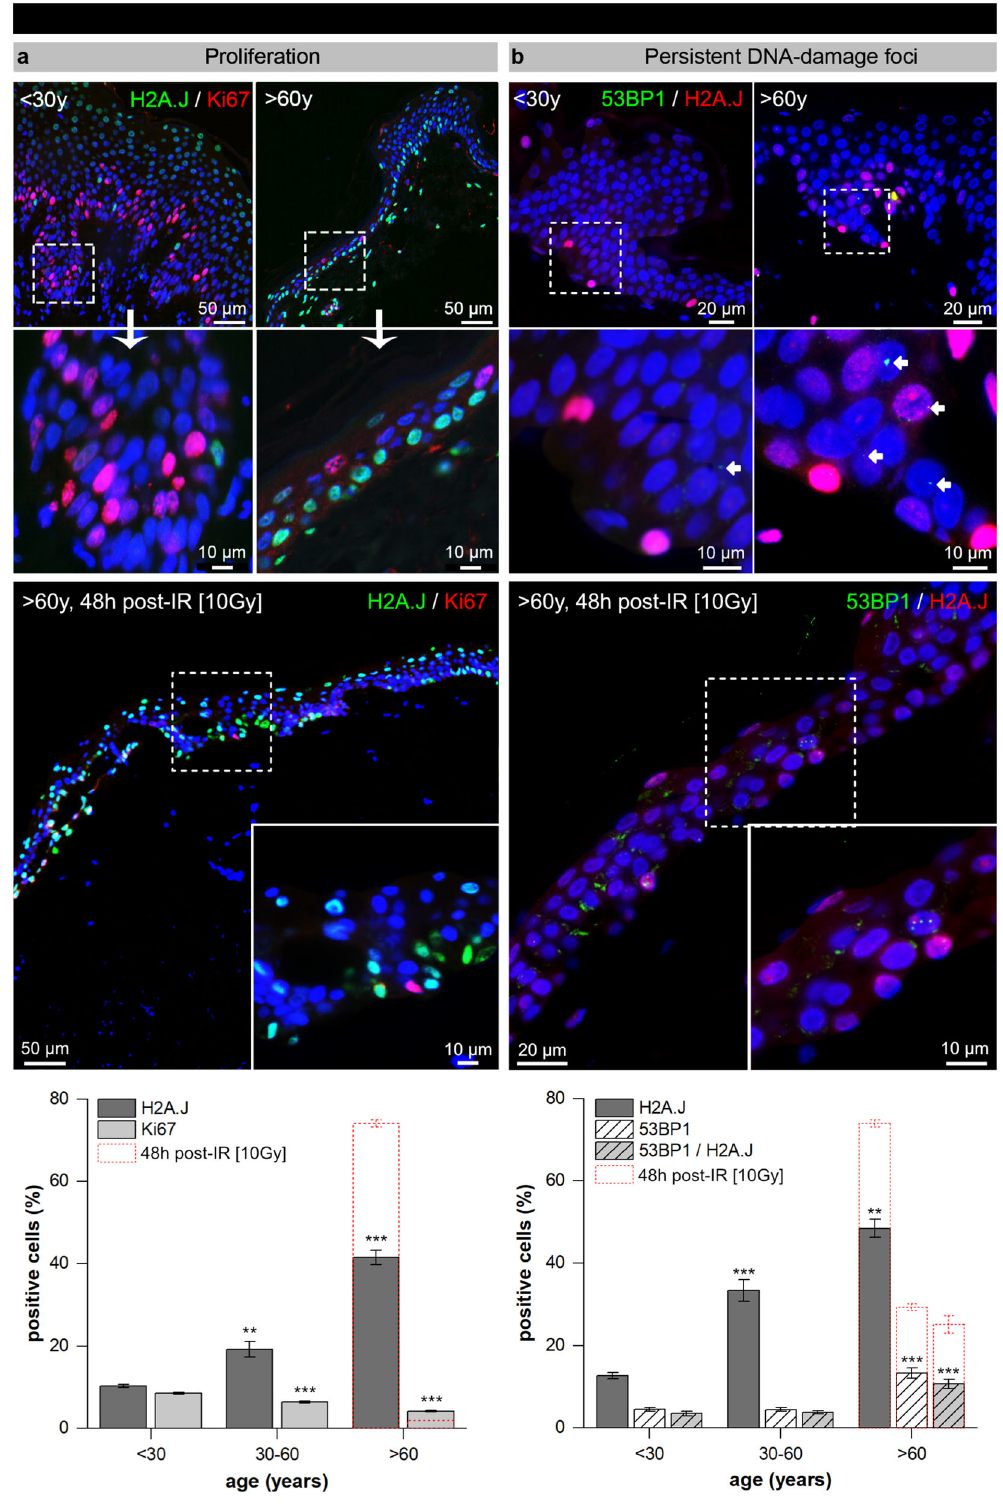
Fig. 2 Proliferative capacity, DNA-damage foci, and H2A.J during human skin aging. a IF micrographs of H2A.J and Ki67 double-staining in young, aged, and irradiated skin (upper panel). Graphic presentation of the quanti fi cation of H2A.J + and Ki67 + cells in epidermis of young (<30 y), middle-aged (30 – 60 y), and aged (>60 y) donors ( n = 3 per age-group). b IF micrographs of 53BP1 and H2A.J double-staining in young, aged and irradiated skin. Graphic presentation of the quanti fi cation of 53BP1 + , H2A.J + , and double-positive cells in epidermis of young (<30 y), middle-aged (30 – 60 y), and aged (>60 y) donors ( n = 3 per age-group). Data are presented as mean±SE; ** p < 0.01, *** p < 0.001 signi fi cant statistical difference to younger age-group. Red, broken lines in the bar graph indicate the results for irradiated